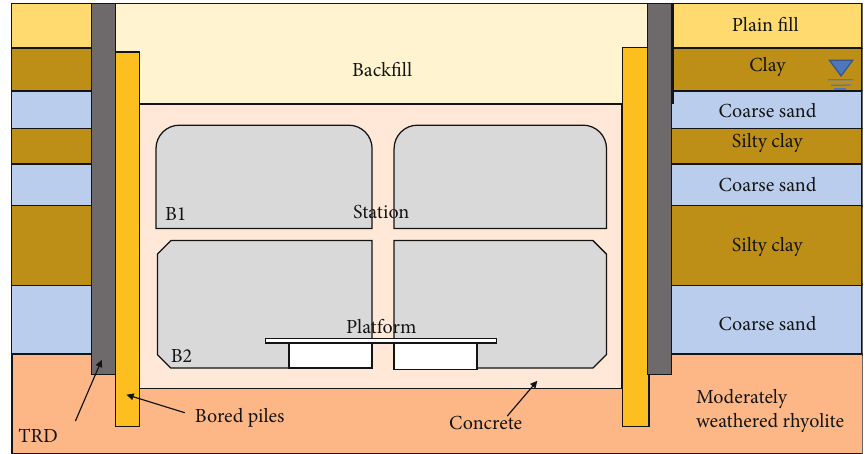
Figure 10: Double-storey station pro fi le.